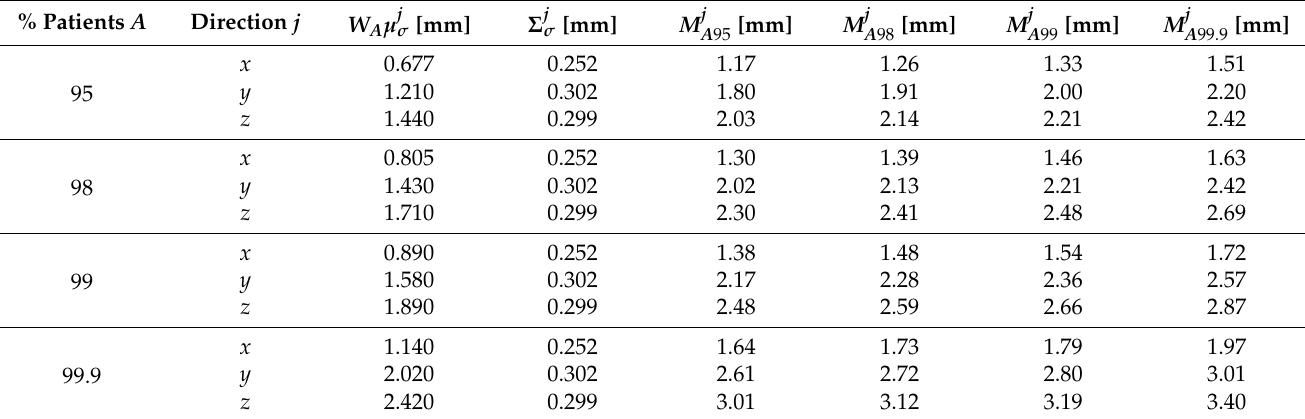
Table 4. Safety margins using the time length intervals I = 100